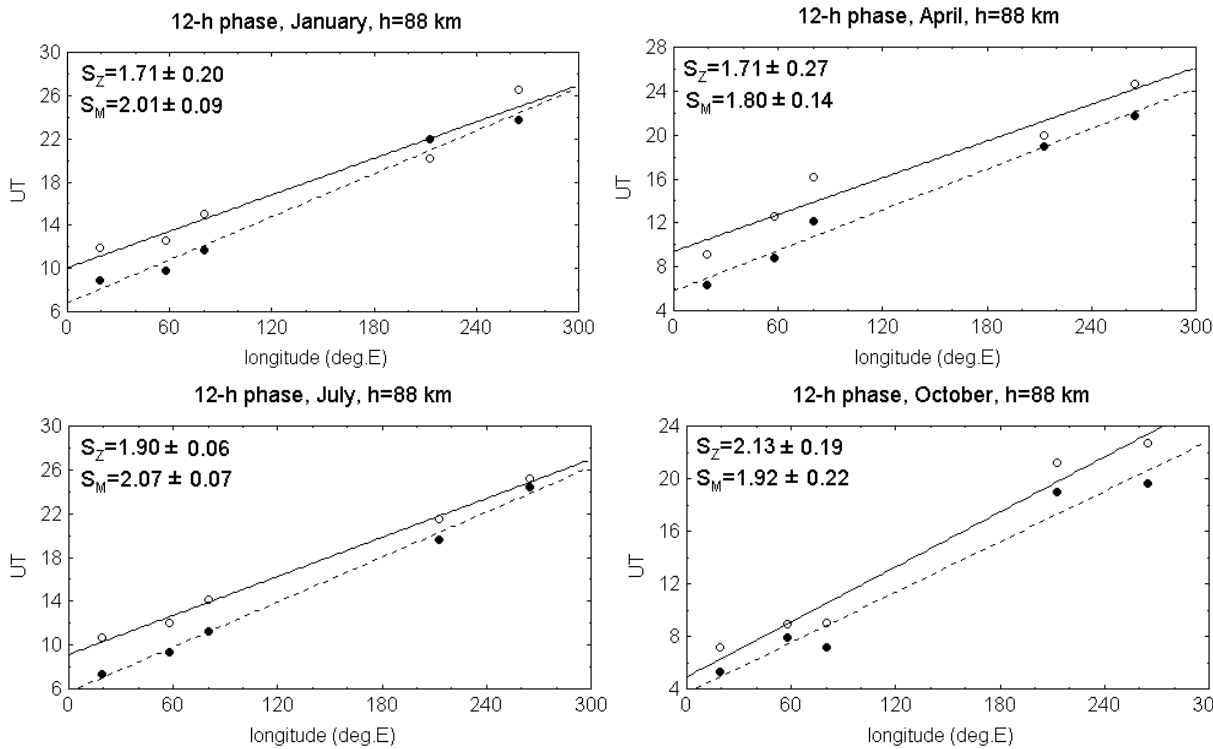
Fig. 10. Dependence of the SDT phases (time of maximum in UT) on longitude − o − zonal component, −•− meridional component